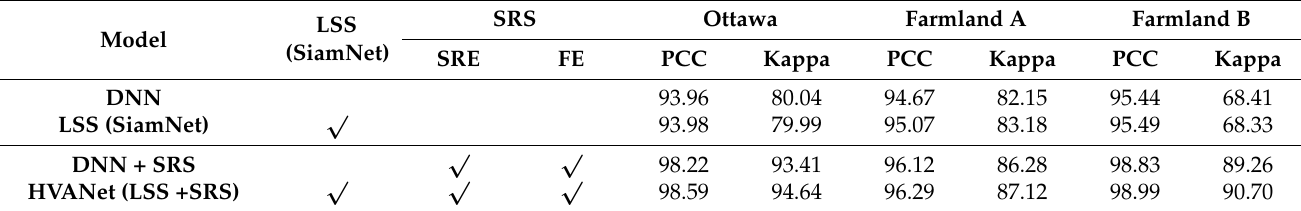
Table 2. Ablation study results of the proposed HVANet on SiamNet.